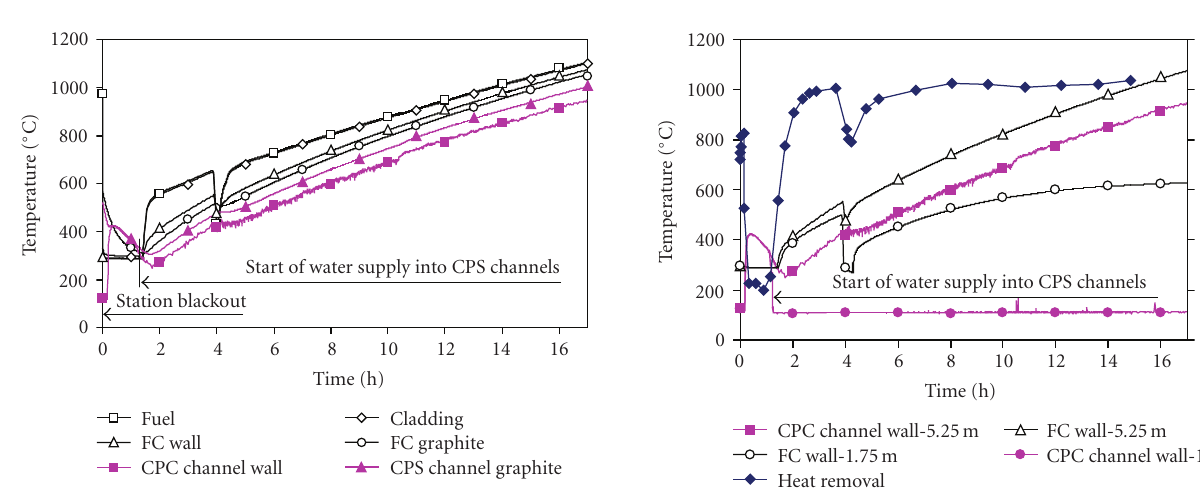
Figure 9: Station blackout case. Heat removal using CPS channels is taken into account. Behaviour of core components temperatures at the elevation 5.25 m from core bottom.